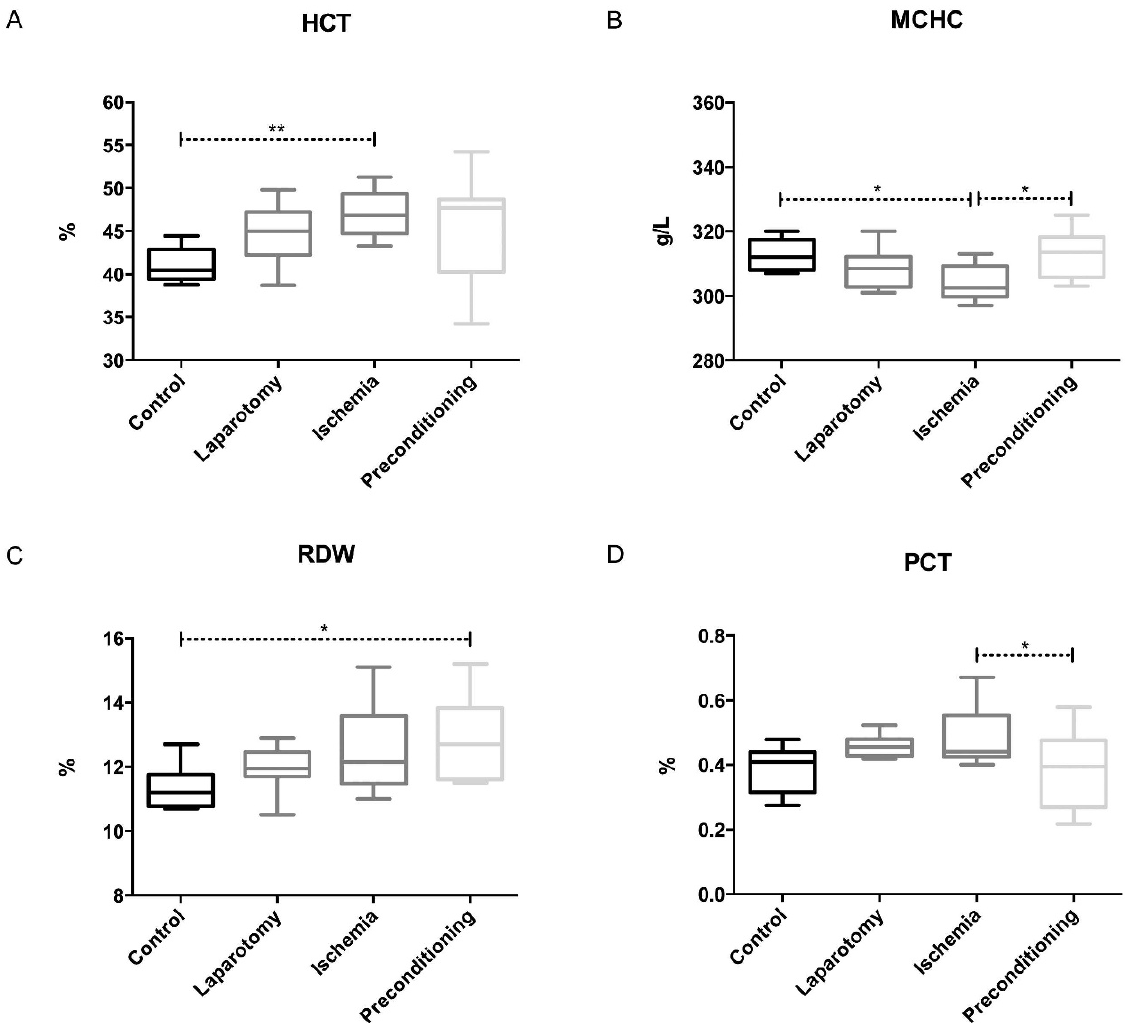
Supplementary Figure 1 - supplementary. Distribution of hematimetric parameters in the four experimental groups. (A) HCT, (B) MCHC, (C) Red cell distribution width and (D) PCT. (** p , 0.001 to 0.01; * p , 0.01 to